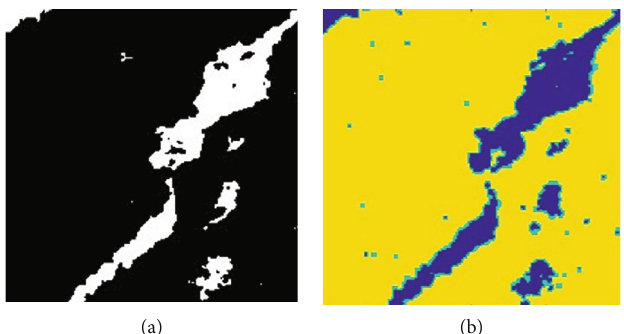
Figure 3: (a) A 2D slice of fractured-porous carbonate rock (pore is white and matrix is black); (b) the image of digital rock constructed by